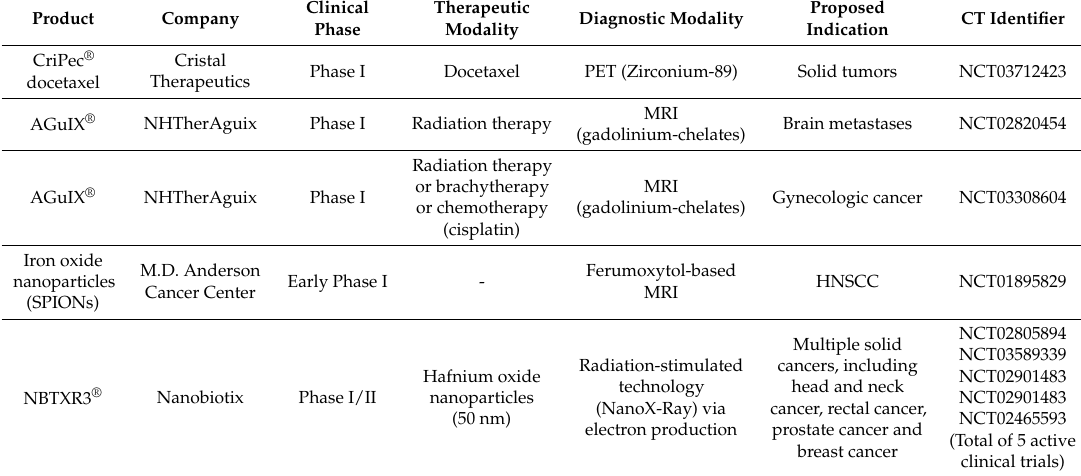
Table 1. Theranostics polymeric and metal-based nanoplatforms under study for clinical applications in different cancers (according to clinicaltrials.gov and